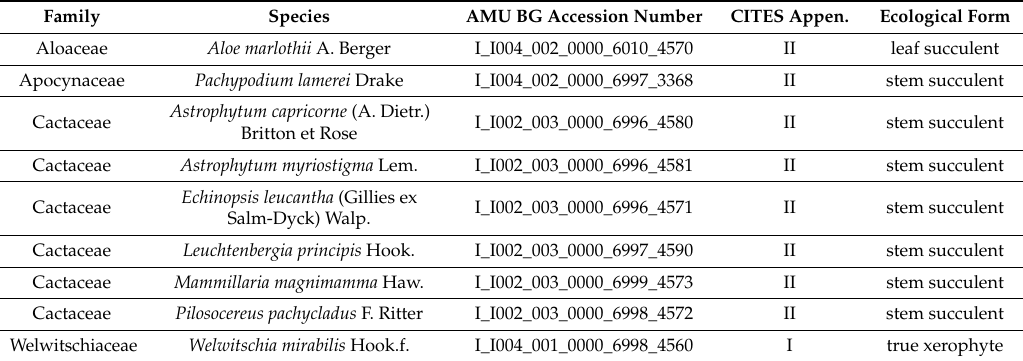
Table 1. List of plant specimens used in the